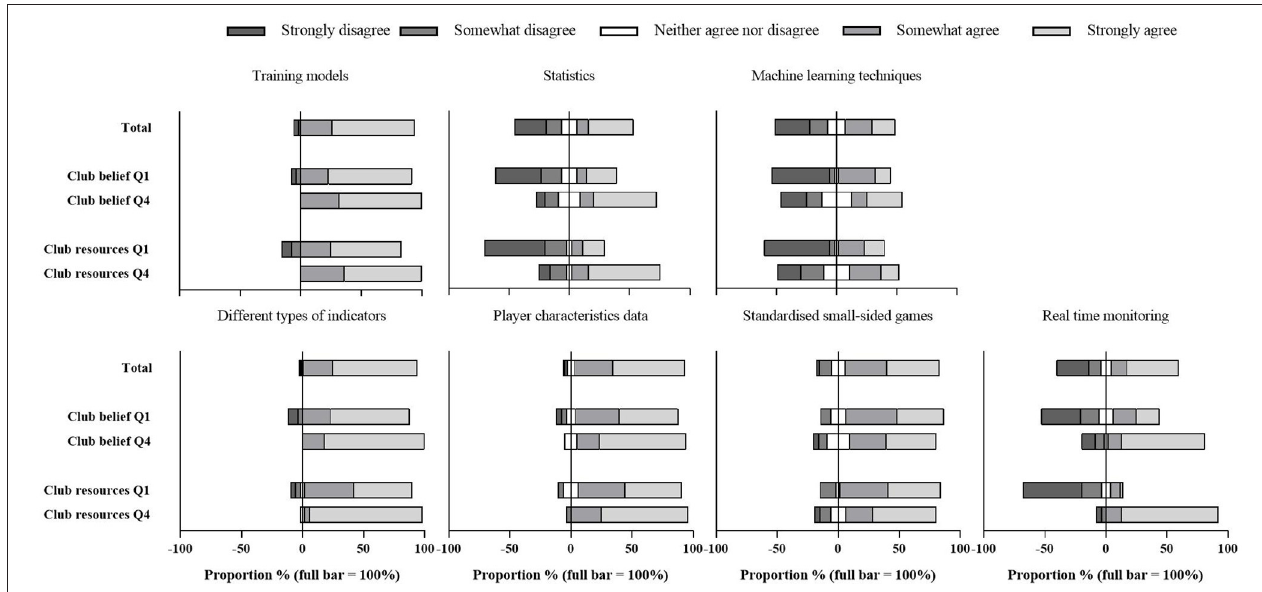
FIGURE 2 | Responses to the seven Likert scale questions examining the analysis methods. Results are presented as the proportion of clubs for the total sample and for quartile 1 (Q1) and quartile 4 (Q4) for both club belief on the benefit of evidence-based practice (EBP) and club financial resources.